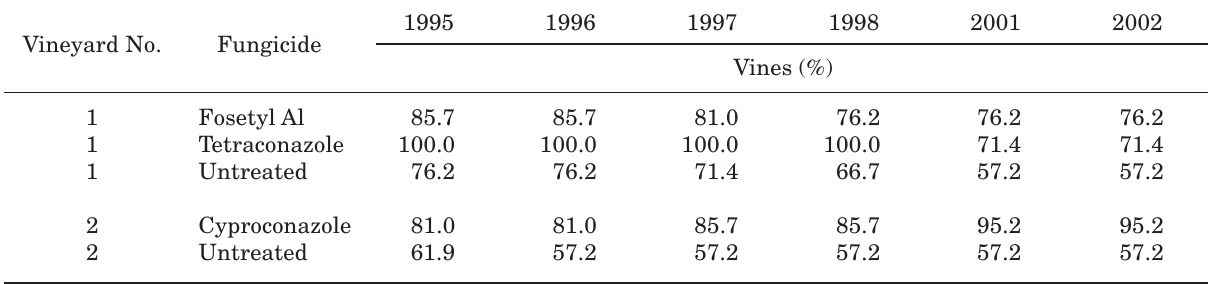
Table 2. Growth resumption in trunk-renewed vines treated with fungicide by trunk